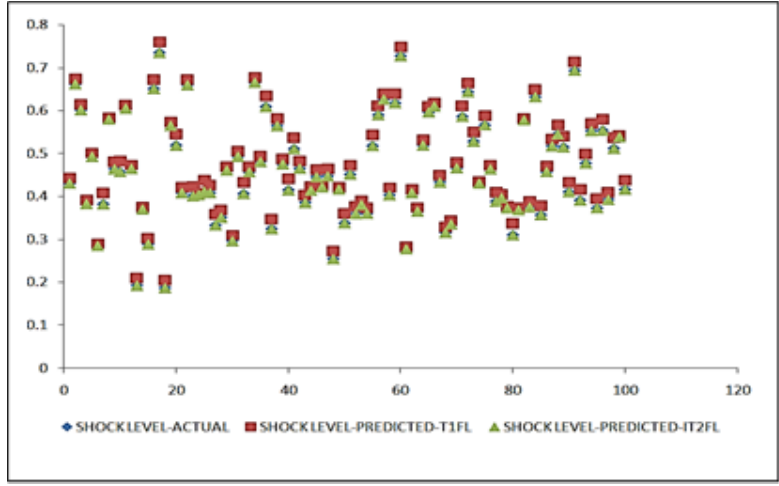
Fig. 12. Plots of the system’s response of actual shock level and predicted shock level for IT2FLS and